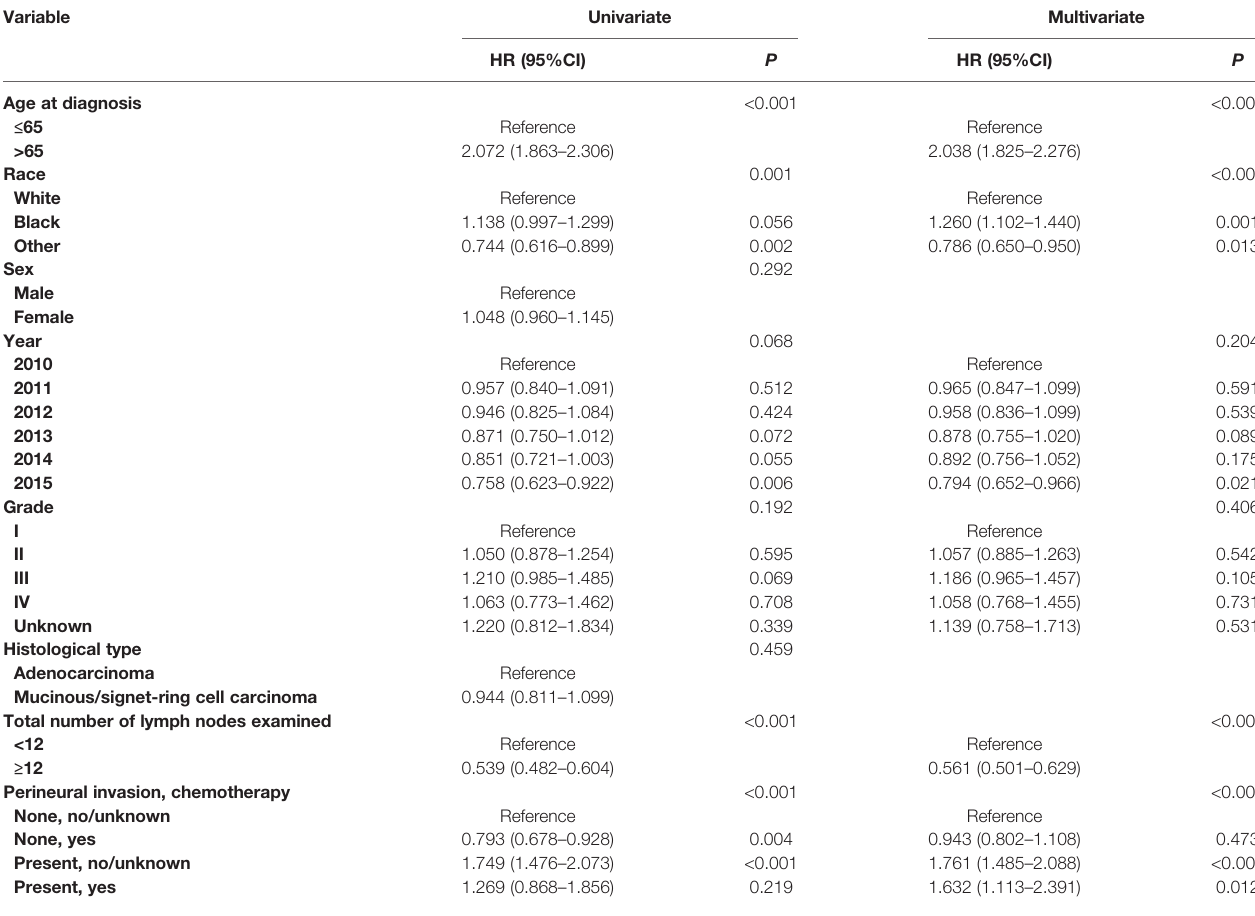
TABLE 4 | Univariate and multivariate survival analyses of T3N0M0 colon cancer.